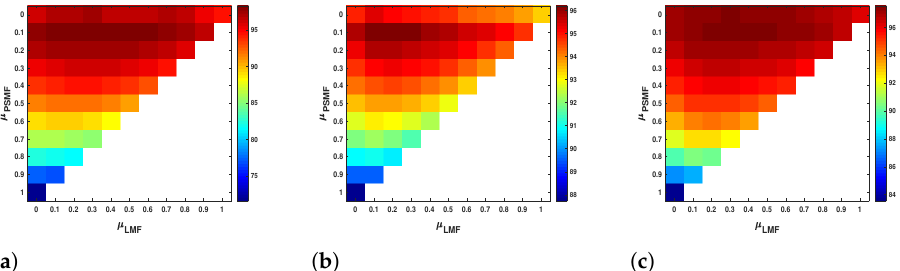
Figure 12. Effect of the kernel weight parameters for ( a ) Flevoland dataset, ( b ) Yihechang dataset, and ( c ) San Francisco